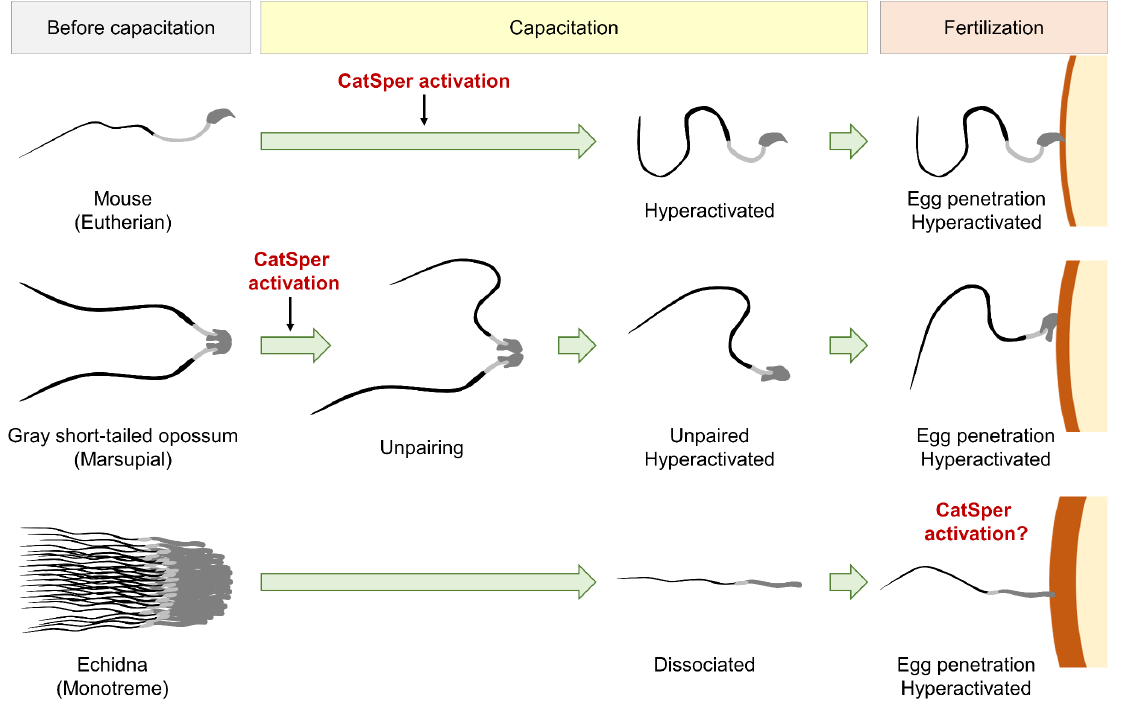
Figure 7. A schematic cartoon depicts sperm hyperactivation in each mammalian lineage. Development of sperm hyper- activation in three mammals, mouse (top), gray short-tailed opossum (middle), and echidna (bottom), which represent each lineage, eutherian, marsupials, and monotreme, respectively, are drawn. Mouse and gray short-tailed opossum sperm develop hyperactivated motility during capacitation, but echidna sperm requires egg contact after dissociation during capacitation to be hyperactivated. Sperm hyperactivation seems to be required to penetrate the egg barrier (right, orange layer) in all three lineages.